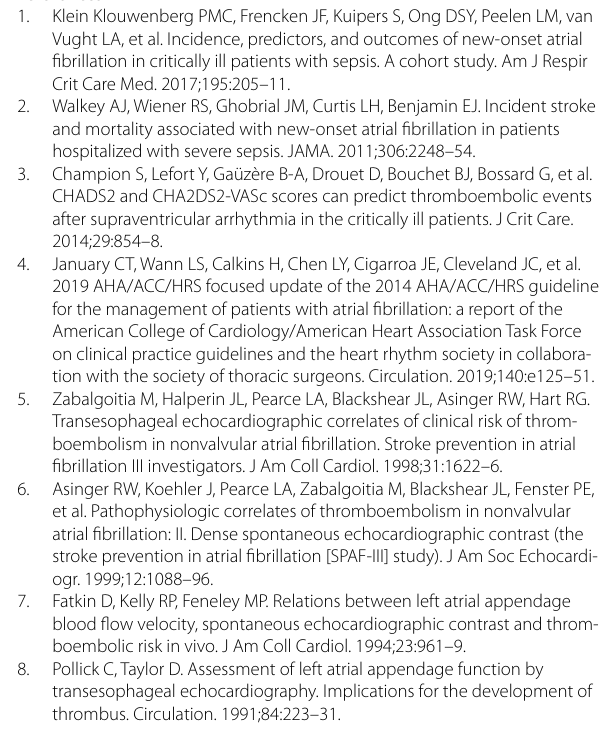
Table S2. Stop Stroke Study Trial of Org 10172 in Acute Stroke Treatment (SSS‑TOAST) Classification Criteria to Determine Causative Subtypes of Acute Ischemic Stroke. Figure S1. The decision algorithm to assign a mechanism using the Stop Stroke Study Trial of Org 10172 in Acute Stroke Treatment (SSS‑TOAST) Classification Criteria. Table S3. Initial transthoracic and transesophageal echocardiographic variables according to 28‑day cardiovascular events. Table S4. New onset atrial fibrillation and sepsis management during 28‑day follow‑up in intensive care unit. Table S5. Description of 28‑day ISTH major bleeding events. Table S6. Baseline clinical characteristics at intensive care unit admission, initial severity and new‑onset atrial fibrillation management according to 28‑day cardiovascular events. Table S7. Multivariate analyses of factors associated with cardiovascular events including baseline clinical characteristics (SAP‑ SII score, CHADS2Vasc2 and HAS‑BLED) and antithrombotic management (antiplatelet therapy and therapeutic anticoagulation on the day of NOAF